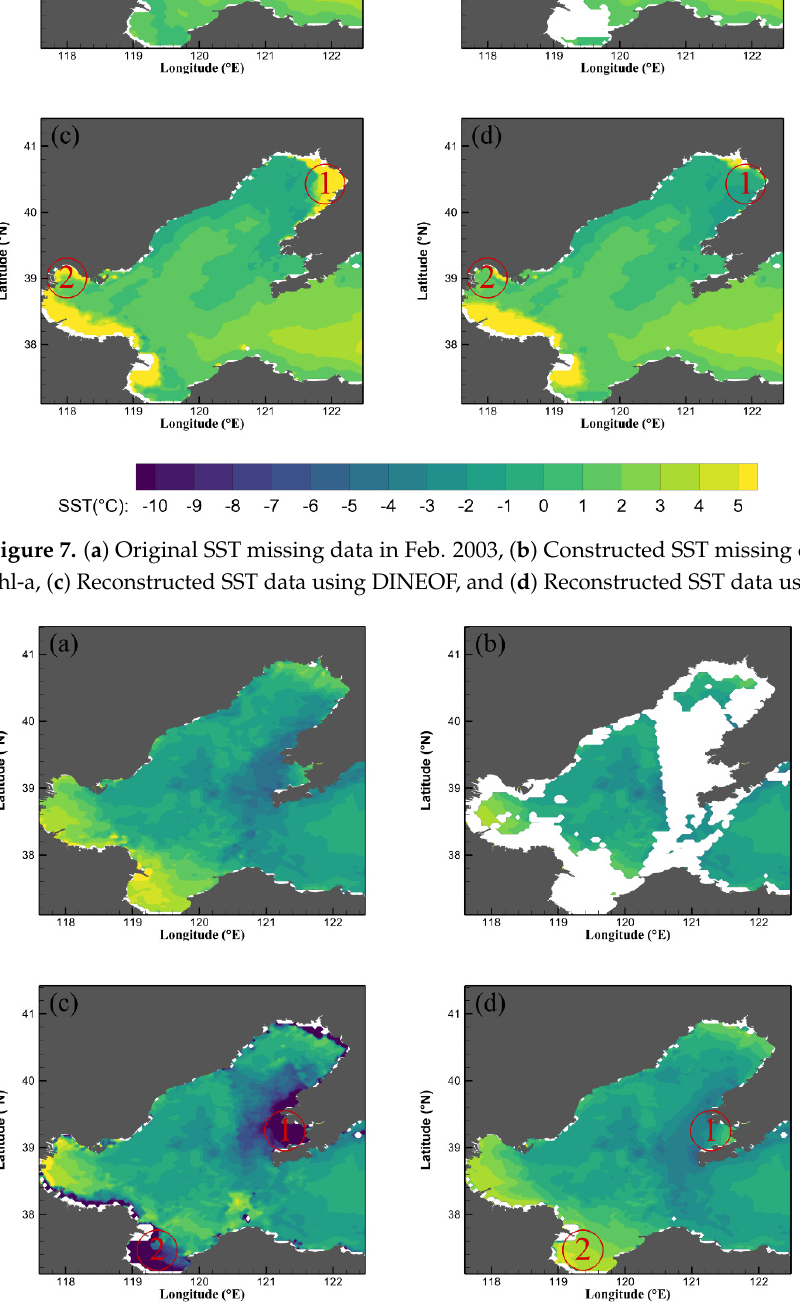
Figure 8. ( a ) Original SST missing data in Jul. 2010, ( b ) Constructed SST missing data according to chl-a, ( c ) Reconstructed SST data using DINEOF, and ( d ) Reconstructed SST data using IV − DINEOF. Compared with the result of the DINEOF algorithm for the June 2013 data, the r and SNR of the IV − DINEOF algorithm increased from 0.3934 and 0.8863 to 0.7350 and 1.3311, respectively; the RMSE and the MAD were reduced from 2.4923 and 1.4579 to 1.6238 and 1.0983, respectively. Comparing Figure 9a,c,d, it can be seen that the reconstruction results of the IV − DINEOF algorithm and the DINEOF algorithm are the same, but the DINEOF algorithm has more extreme values in the data along the shoreline.